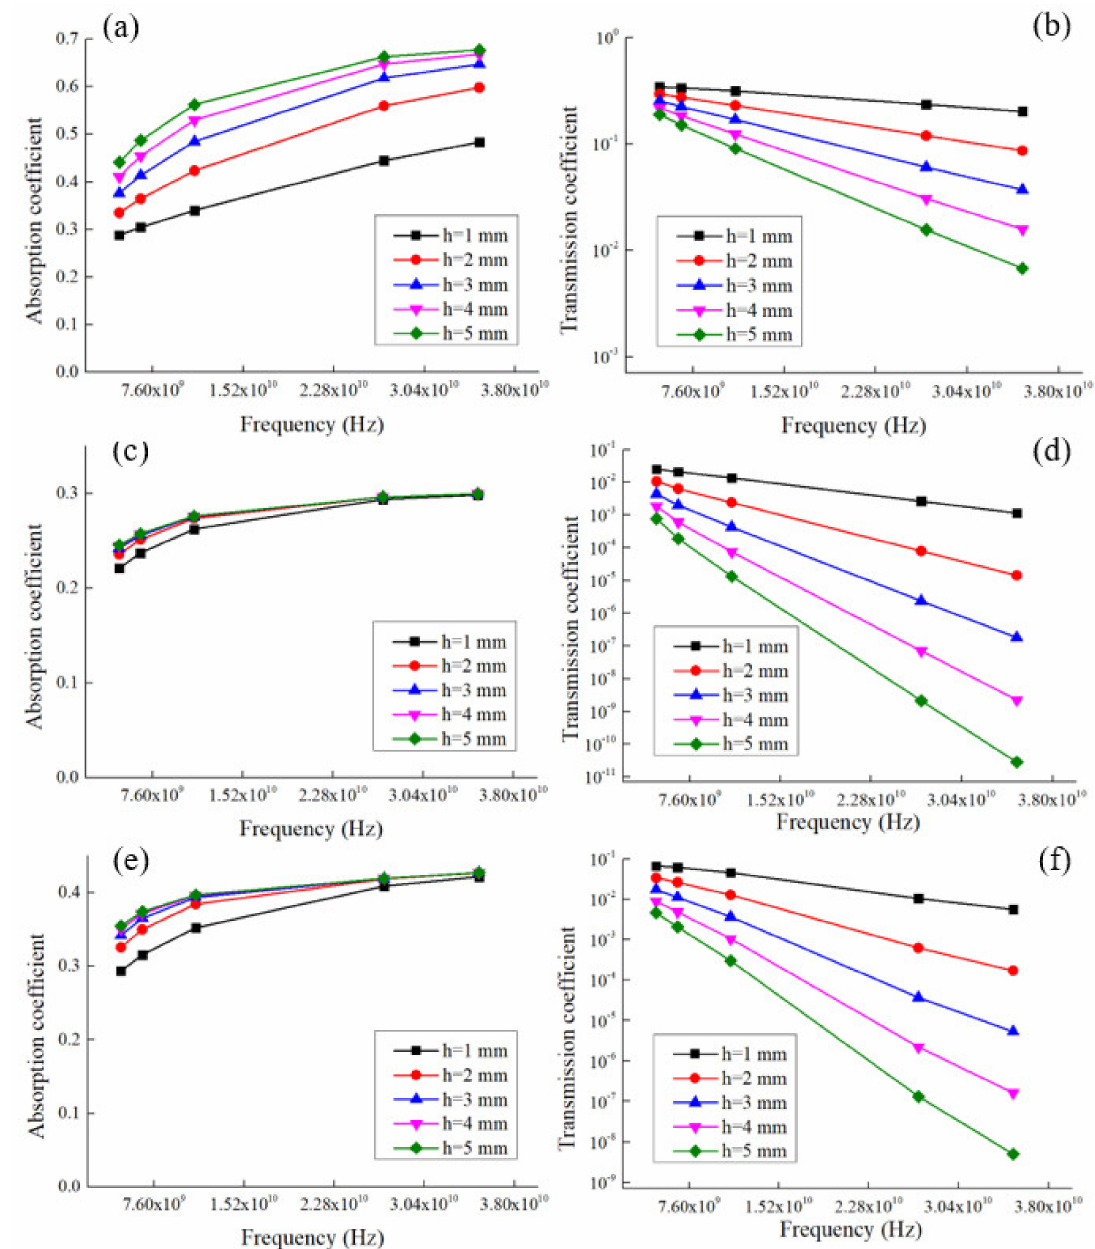
Figure 6. Frequency dependence of absorption coefficient ( a , c , e ) and transmission coefficient ( b , d , f ) for 1FPC-0, 1FPC-50 and 1FCP-100 samples,